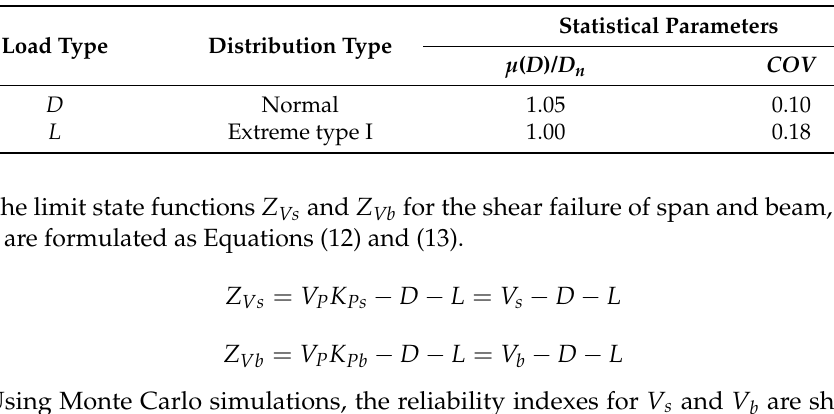
Table 7. Probabilistic properties for the dead load D and live load L .